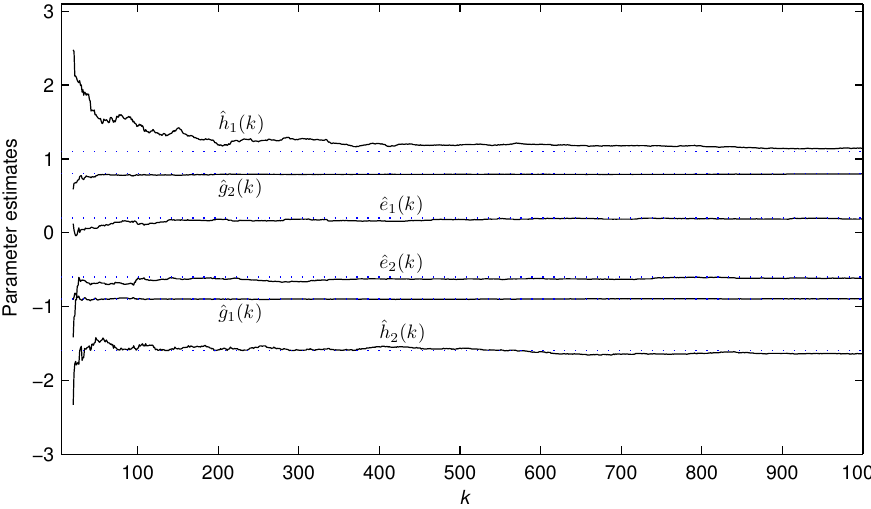
Figure 2. The parameter estimates ˆ θ ( k ) versus k for Example